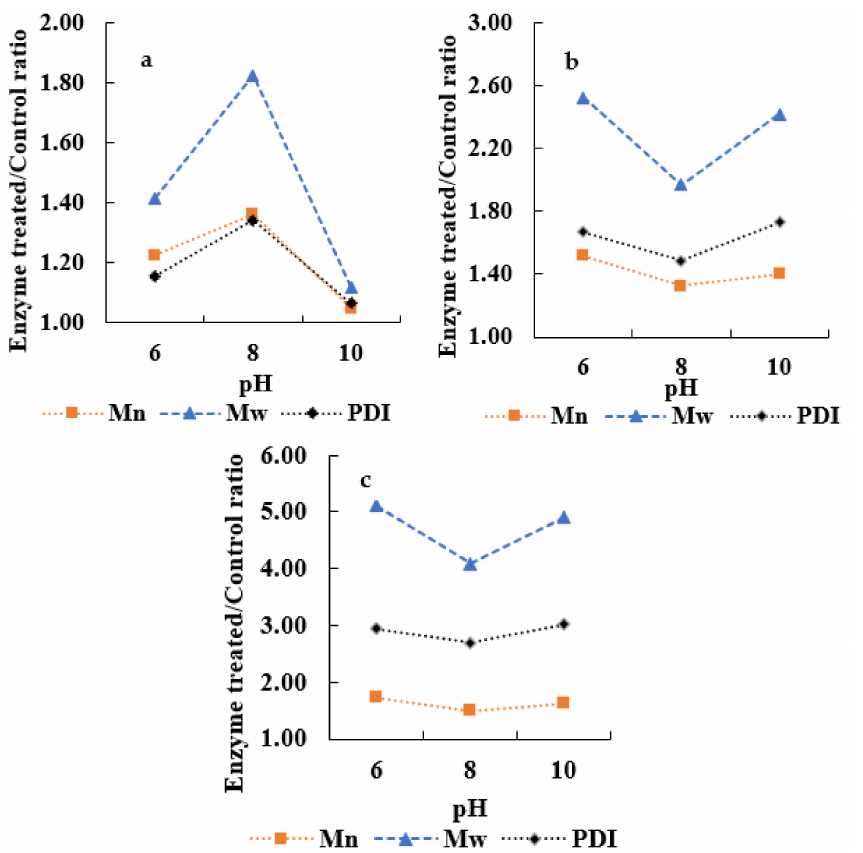
Figure 3. ( a ) AmLac , ( b ) SvLac , and ( c ) ScLac activities on APL at different pH (6, 8, an d10) in B&R buffer. Here, the weight average molecular weight (Mw), number average molecular weight (Mn), and polydispersity Index (PDI) values before and after the enzymatic treatments were divided with the control average molecular weight values (APL without laccase) to show the degree of enzymatic conversion.